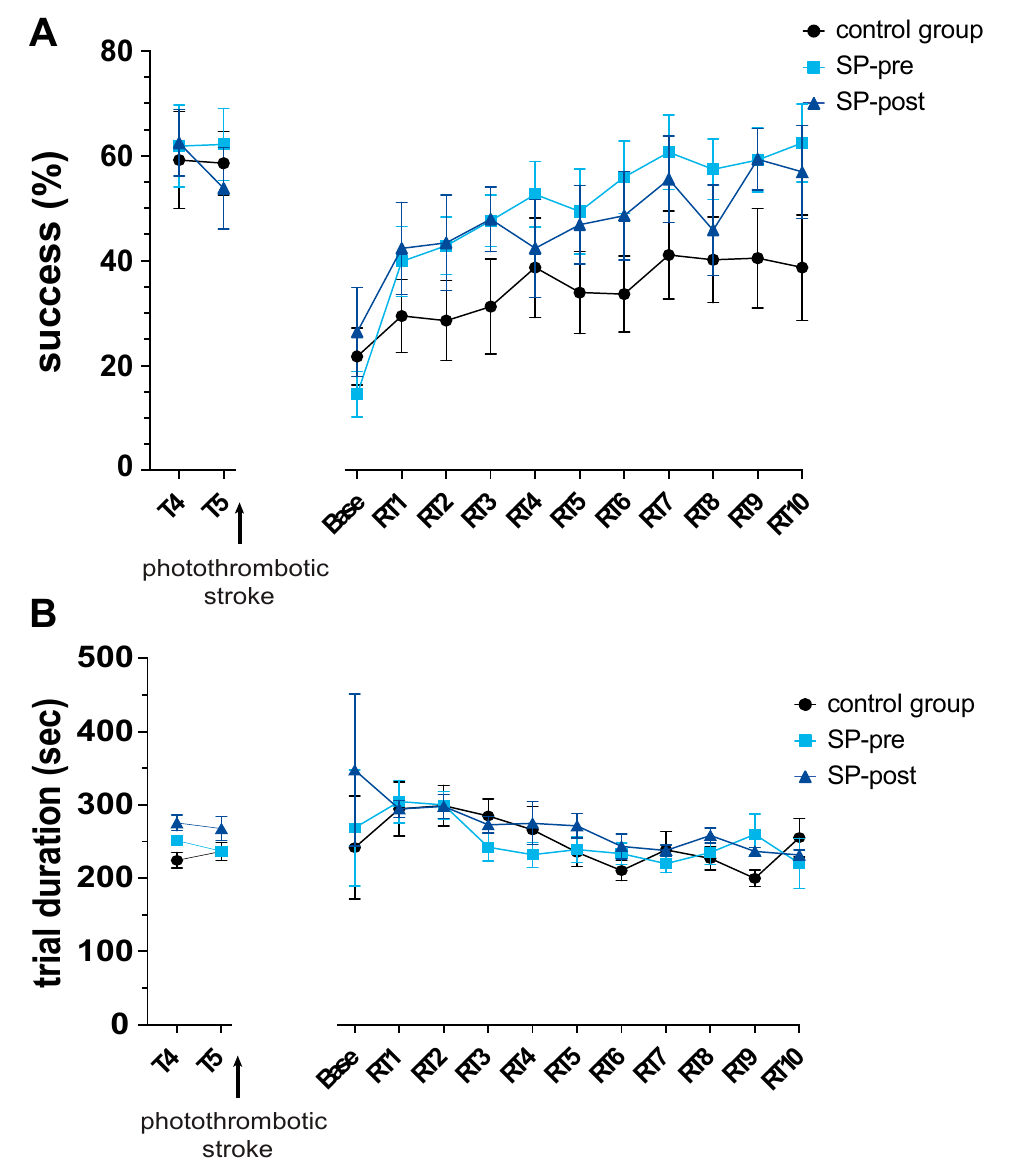
Figure 2. Intraperitoneal Substance P application facilitates motor rehabilitation after stroke. ( A ) After stroke, all groups showed a similar drop in performance. Administration of SP (SP-pre: 250 µ L i.p. 30 min before training sessions RT1-10; SP-post 250 µ L i.p. 16 h after training sessions RT1-10) significantly improved rehabilitation success compared to saline-treated controls. ( B ) Trial durations as a measure of motivation did not differ between groups. Data are presented as mean ± SEM. 2.2. Dopaminergic Neurodegeneration after Stroke Is Attenuated by Substance P After stroke, TH-positive neurons were reduced by 33% in the ipsilesional compared to the contralesional midbrain in the control group (Figure 3A, ipsi: 1002 ± 315.7 cells, contra: 1496 ± 526.4 cells, n = 6, paired t -test p = 0.0079). Considering mesencephalic subfields, TH-positive neurons were reduced significantly in the ventral tegmental area (ipsi: 484.8 ± 135 cells, contra: 632.2 ± 200.8 cells, paired t -test p = 0.028), the substantia nigra pars compacta (ipsi: 409.5 ± 149.0 cells, contra: 681.5 ± 256.6 cells, paired t -test p = 0.0046, Figure 3E) and the retro rubral field (ipsi: 81.0 ± 71.84 cells, contra: 148.2 ± 99.01 cells, paired t -test p = 0.029). In the SP-pre group, no significant reduction in TH-positive midbrain neurons could be observed (Figure 3B, ipsi: 1459 ± 845.4 cells, contra: 1597 ± 1034 cells, n = 7, Wilcoxon matched pairs signed-rank test p = 0.297). Mesencephalic subfields showed no